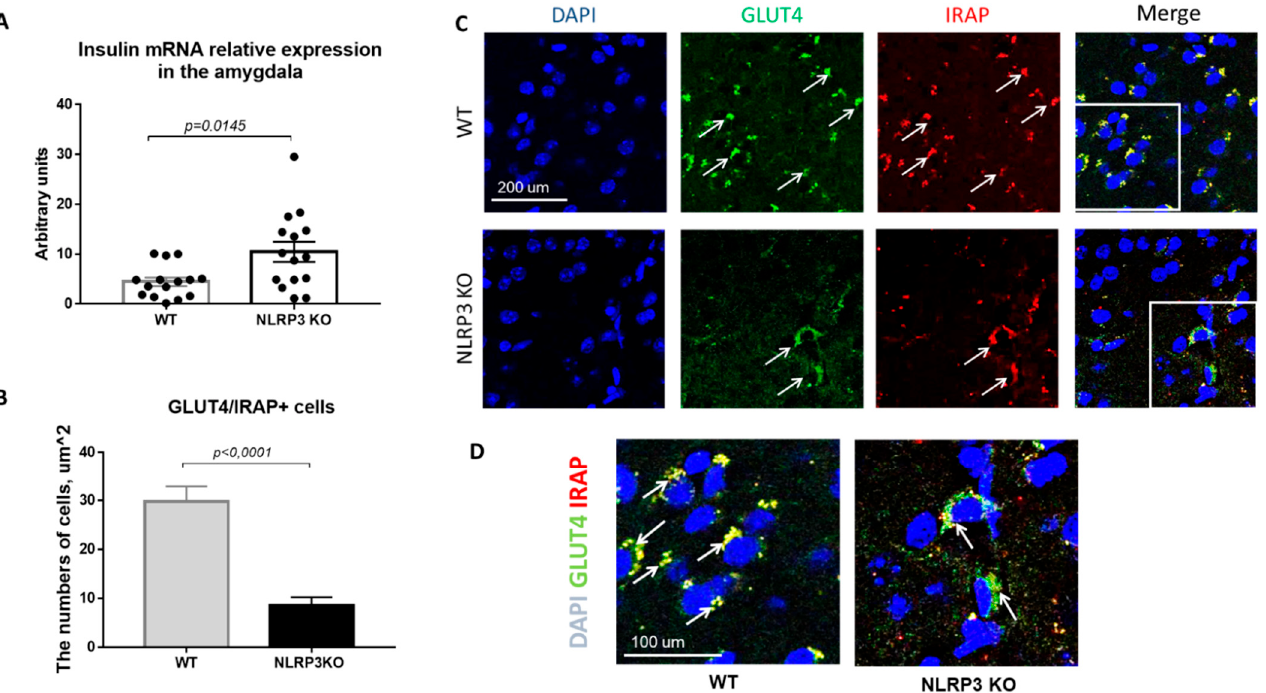
Figure 8. Evaluation of insulin mRNA and expression of GLUT4 and IRAP molecules in the basolateral amygdala of the mouse brain. ( A ) Insulin mRNA in arbitrary units (AU). ( B ) Number of GLUT4/IRAP + cells. ( C ) Triple immunofluorescent staining: cell nuclei—DAPI (blue), GLUT4 expression (green), IRAP expression (red), signal overlay (Merge). Scale Bar— 200 μ m. ( D ) Superposition of signals with triple immunofluorescent staining: cell nuclei DAPI (blue), GLUT4 (green), IRAP (red). Scale Bar—100 microns. WT—control mice group, NLRP3 KO—NLRP3 knockout mice.